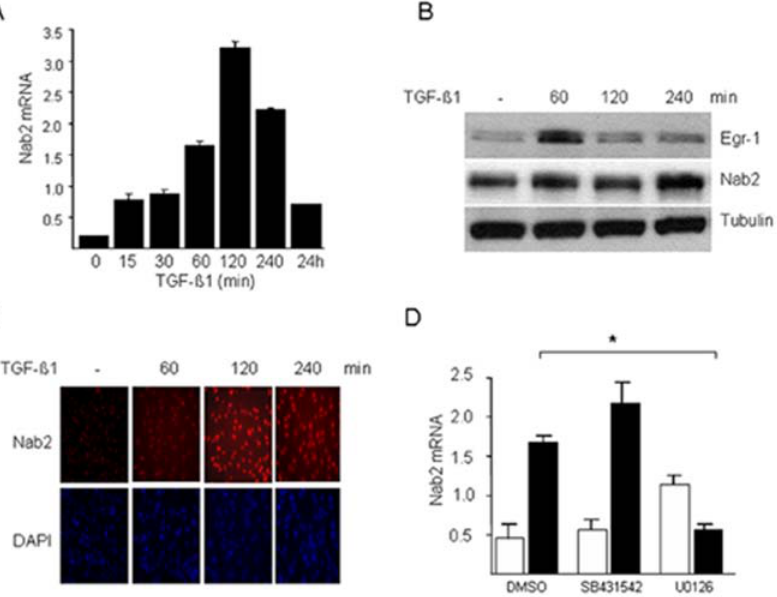
Figure 1. TGF- b stimulates Nab2 expression. Confluent cultures of human foreskin fibroblasts were incubated with TGF- b 1 (10 ng/ml) for indicated periods. A, D Total RNA was isolated and analysed by real-time quantitative PCR. Results, normalized with actin, are the means 6 S.D. of triplicate determinations from a representative experiment. B. Whole cell lysates were subjected to Western analysis. Representative immunoblots. C. Fibroblasts were fixed and stained with anti-Nab2 antibodies, or DAPI to detect nuclei, and viewed by immunofluorescence microscopy (original magnification 6 100).